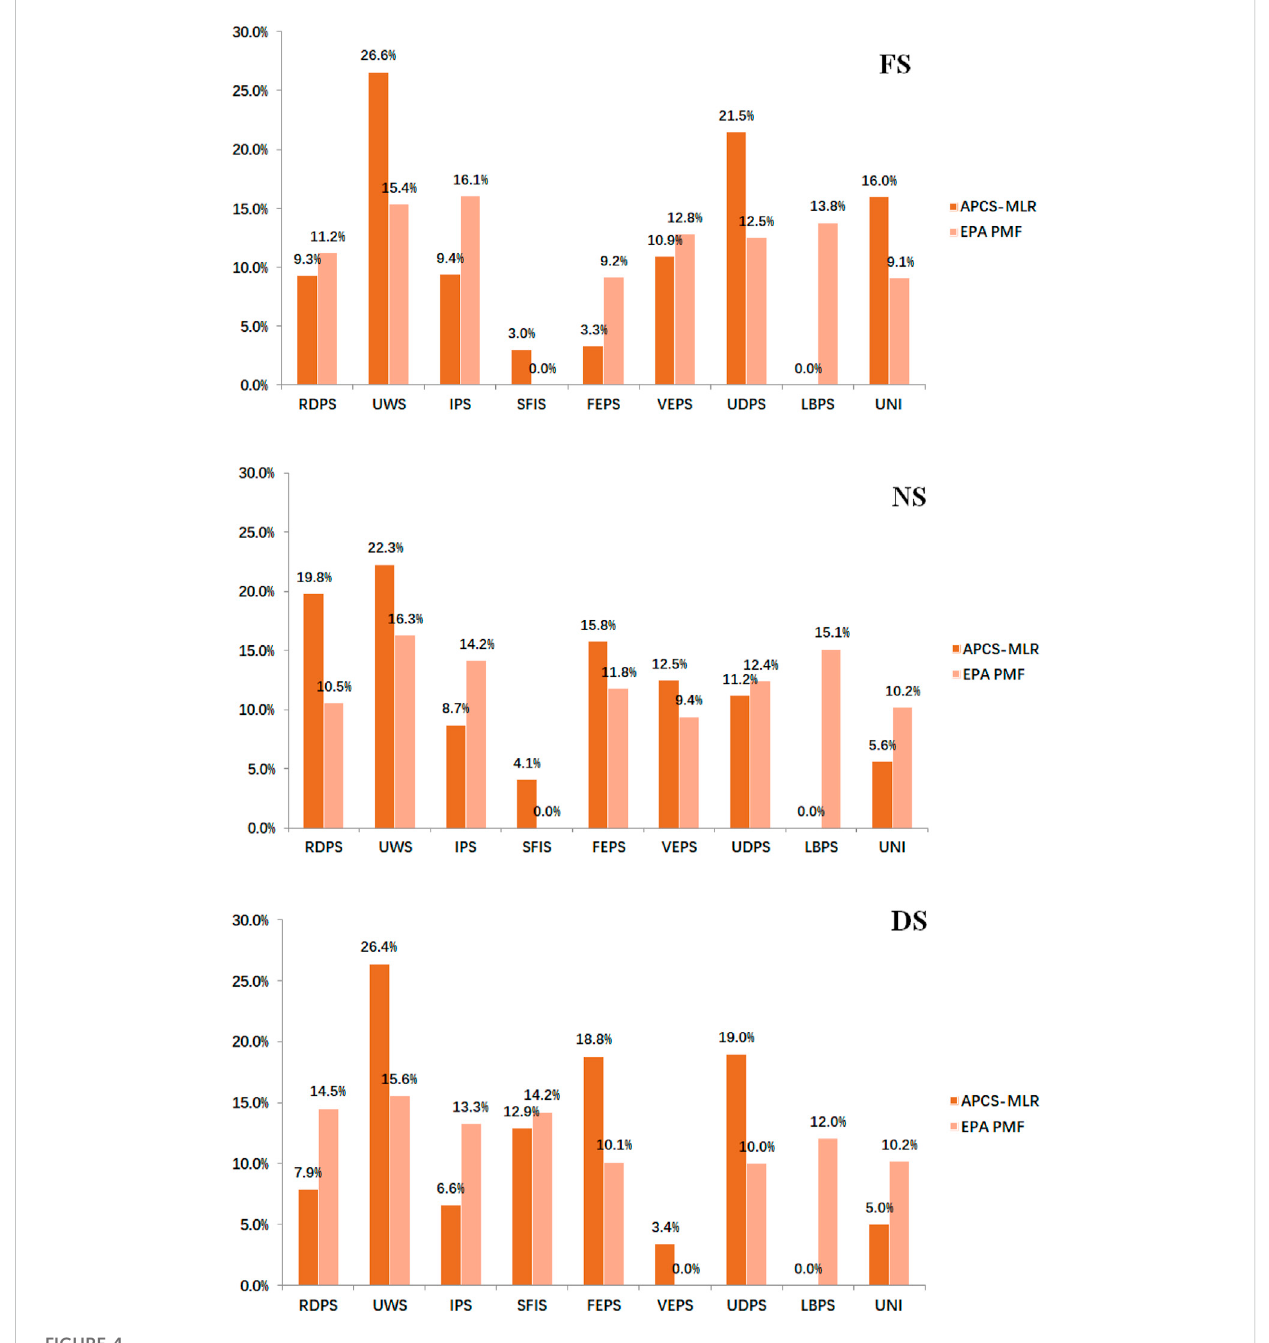
Pollution distribution rate in FS, NS, and DS (column